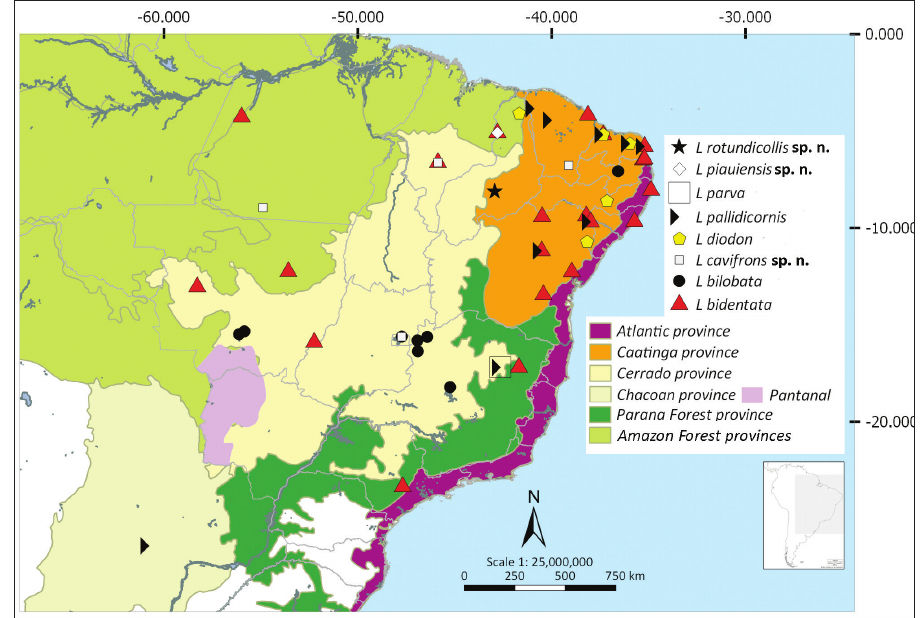
Figure 89. Distribution records of eight species of Liogenys . Biomes based on Morrone (2014). elevated; pygidium convex or flat, as wide as it is long, pygidial disc bristled only on apex; male genitalia, width of basal region equal to the parameres together at its transverse midline; total length of parameres more than five times the length of their apex; inner margins convergent; apex harpoon-like with lateral angle curved projecting perpendicularly to parameres (Fig.